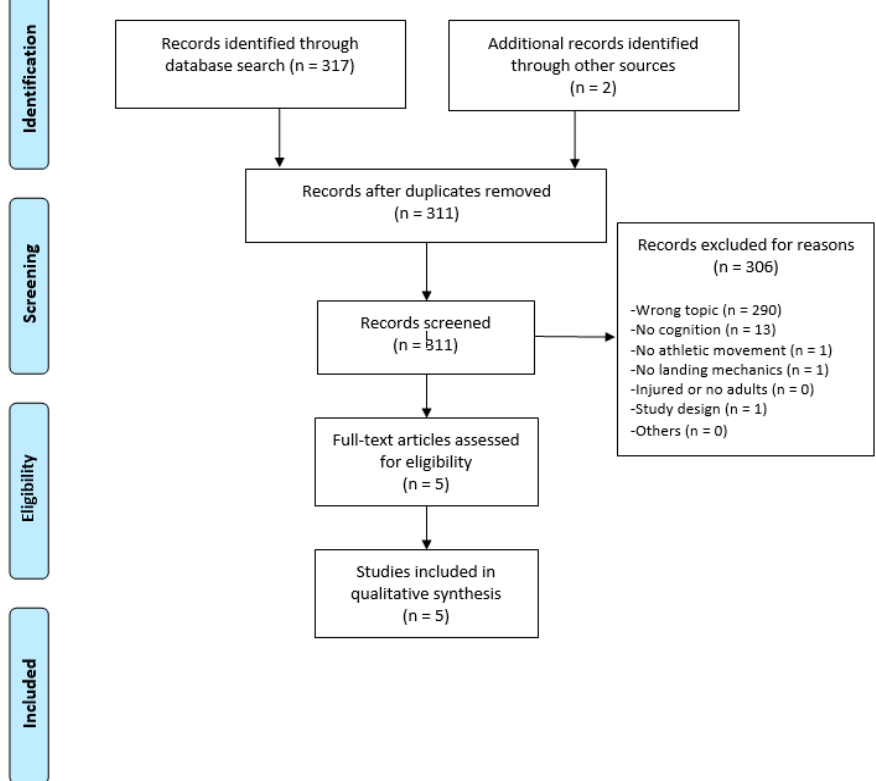
Figure 1. Chart displaying the literature search.